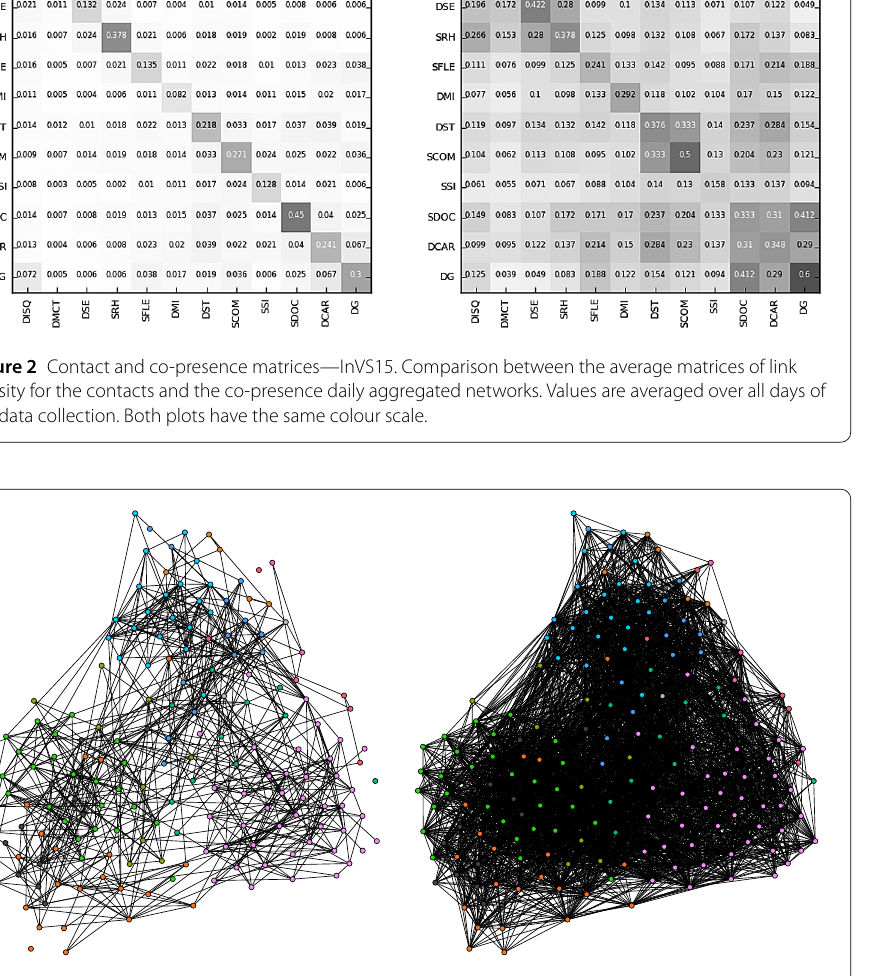
Figure 3 Day 2 contact and co-presence networks—InVS15. This figure highlights the difference in terms of link density when comparing contact and co-presence daily networks. Different node colours correspond to the different administrative